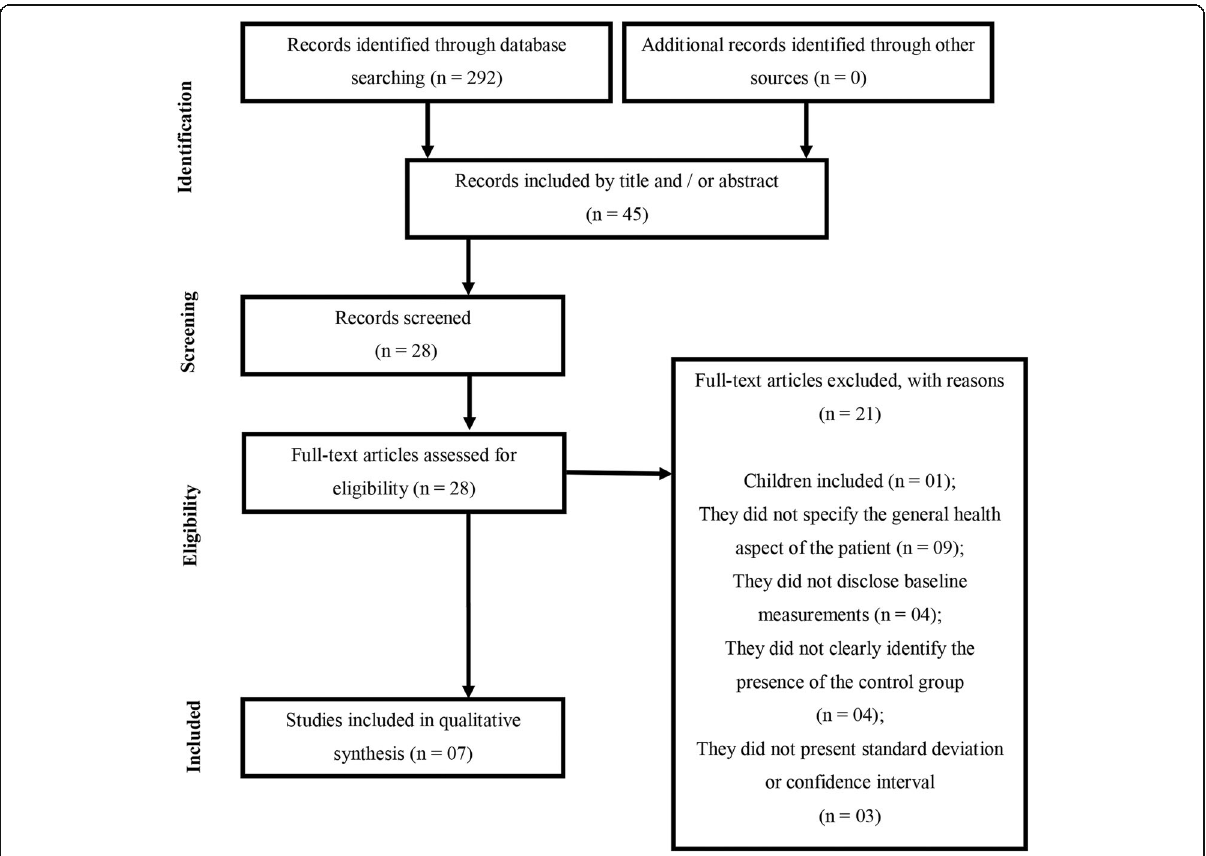
Fig. 1 Flowchart of the article selection